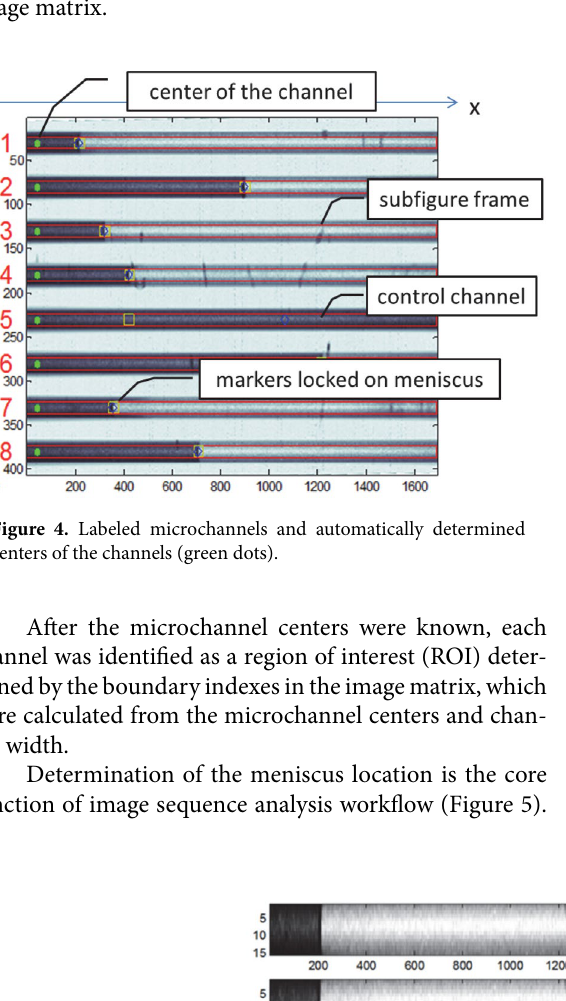
Figure 6. Subtraction of consecutive images.